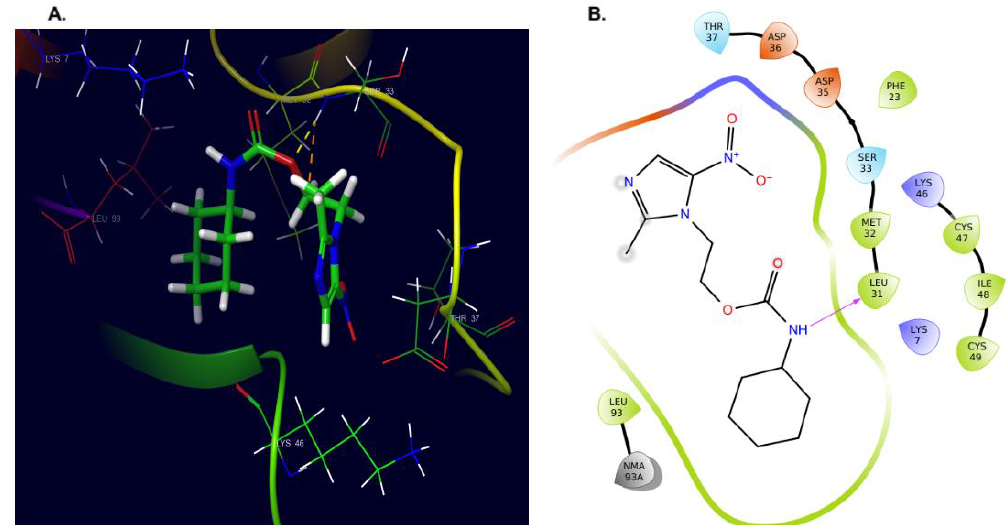
Figure 4. ( A) 3D and ( B ) 2D representations of the binding model of compound 1 in the proposed site for metronidazole in pyruvate – ferredoxin oxidoreductase (PFOR).